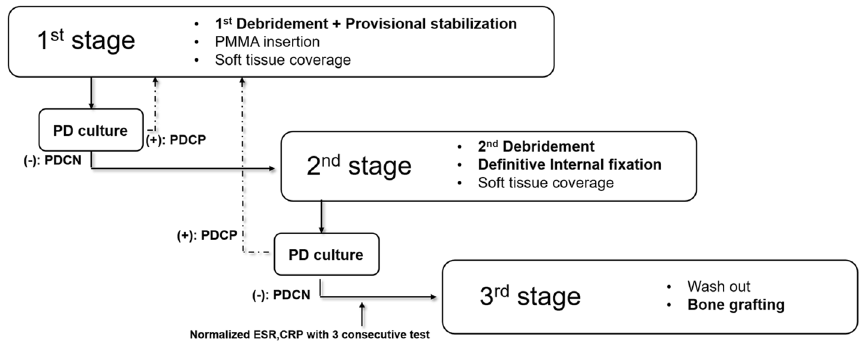
Figure 2. Author’s PDC based multi-staged induced membrane technique. The first stage involved thorough debridement and antibiotics loaded cement spacer insertion, followed by temporary stabilization using an external fixator, temporary plating, an antibiotic-loaded cement rod, or a combination thereof. The second stage included secondary debridement and conversion to the definitive fixation construct using an antibiotic-